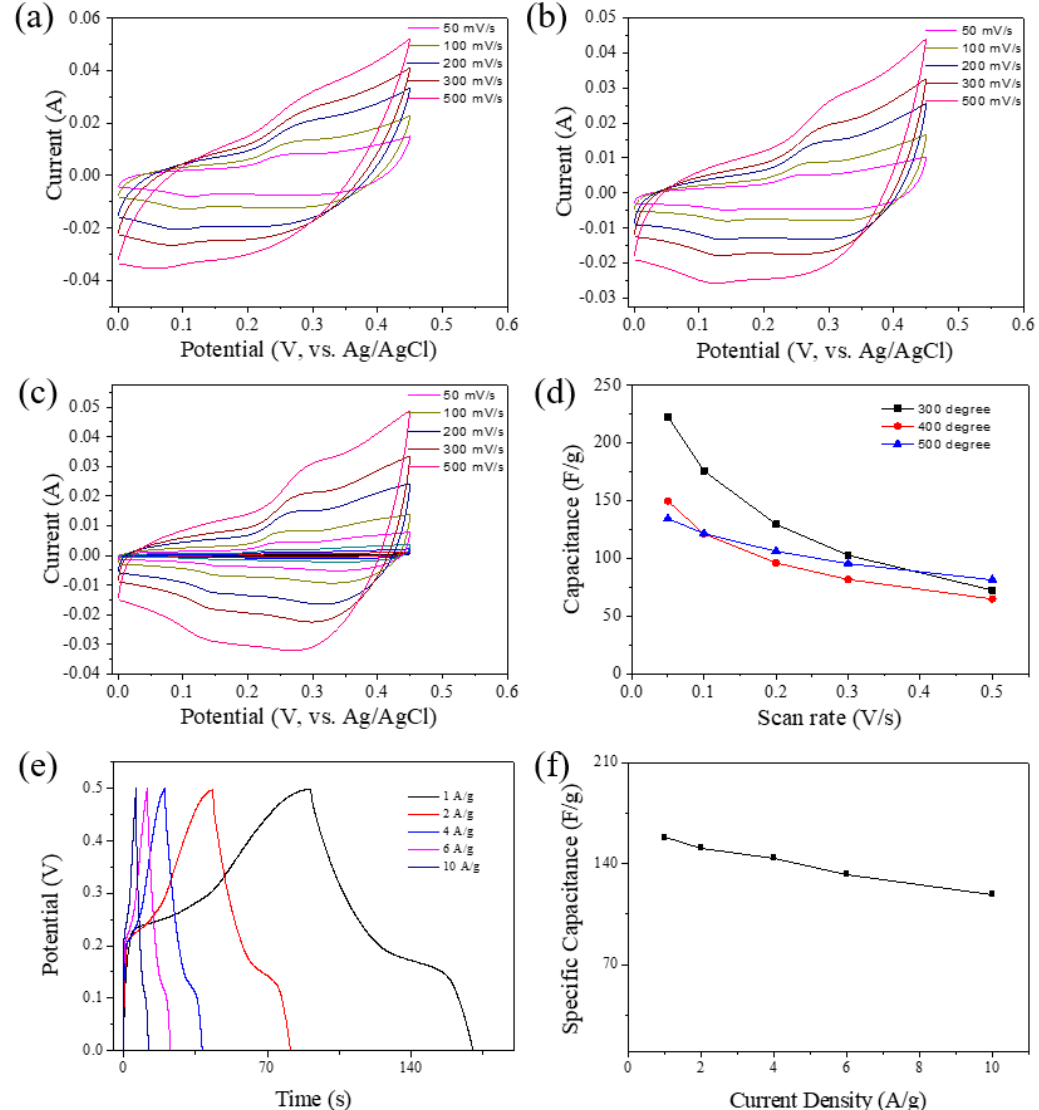
Figure 6. CV curves of Cu-Ni oxides calcined at ( a ) 300 °C, ( b ) 400 °C, and ( c ) 500 °C at various scan rates (( a ) Cu-Ni_0.20_300, ( b ) Cu-Ni_0.20_400, and ( c ) Cu-Ni_0.20_500). ( d ) Specific capacitance versus scan rate plots for all the samples. ( e ) GCD curves and ( f ) specific capacitance of Cu-Ni_0.20_300 at different current densities.